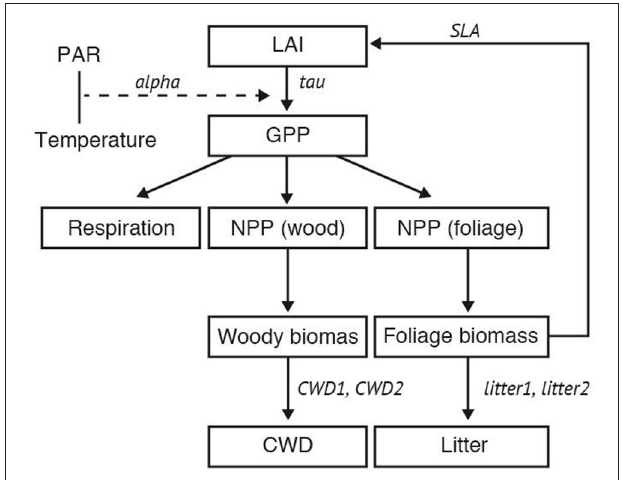
FIGURE 1 | Schematic diagram of SSSEM. Parameters for optimization were listed in Table 1 .